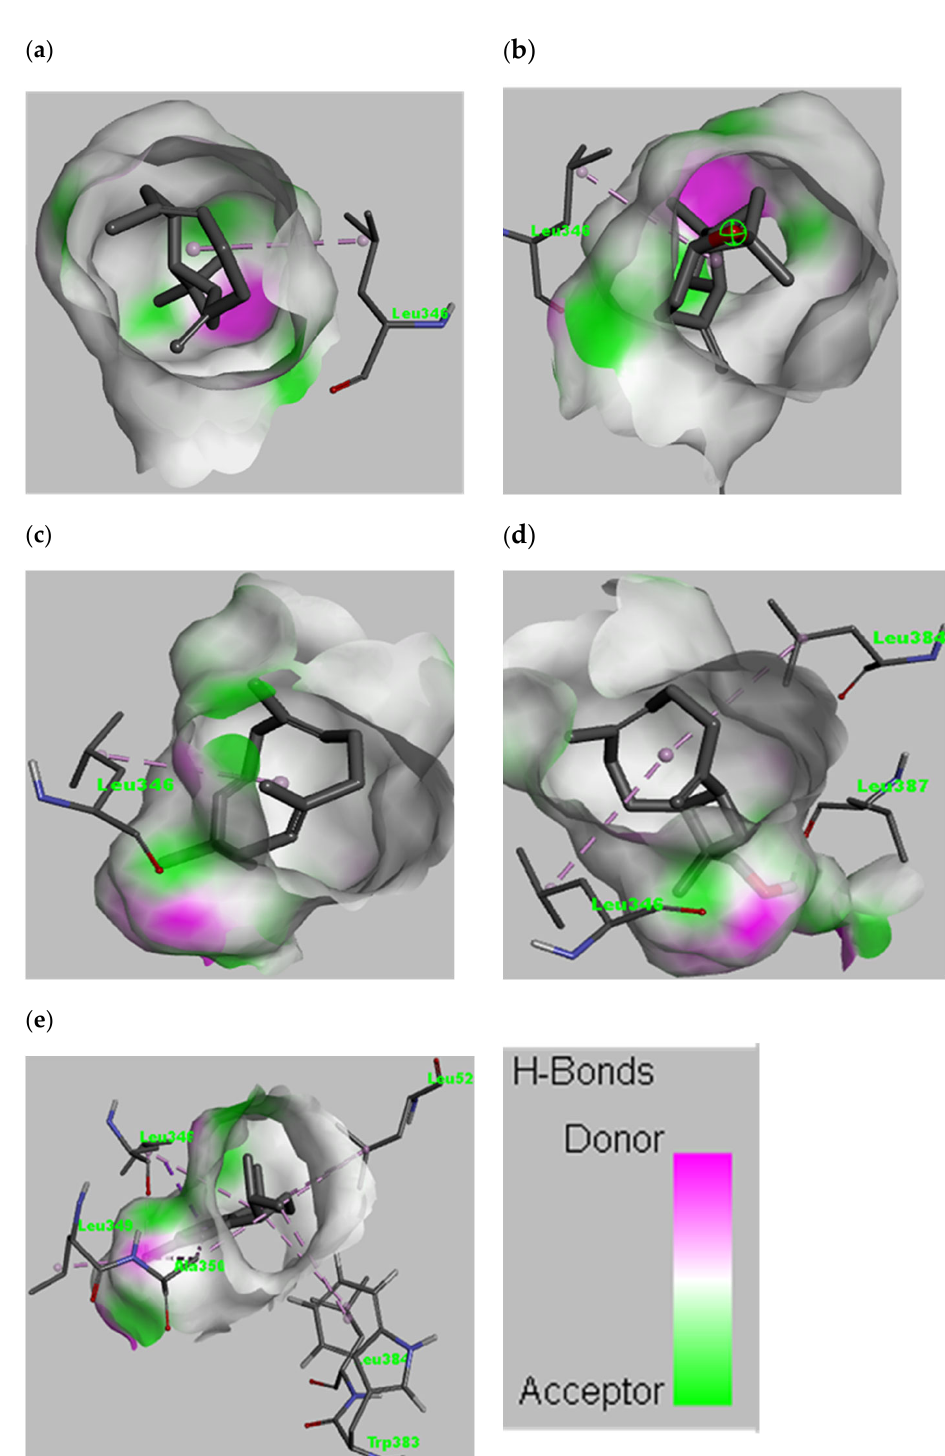
Figure 5. Interactions between the protein molecule and ligands shown in a 3D representation. Only interacting atoms are shown. ( a ) cryophyllene, ( b ) cryophyllene oxide, ( c ) humulene, ( d ) 14-hydroxy-9-epi-(E)-caryophyllene, and ( e ) calamenene. The H bond donor and acceptor tendency is given in color index.